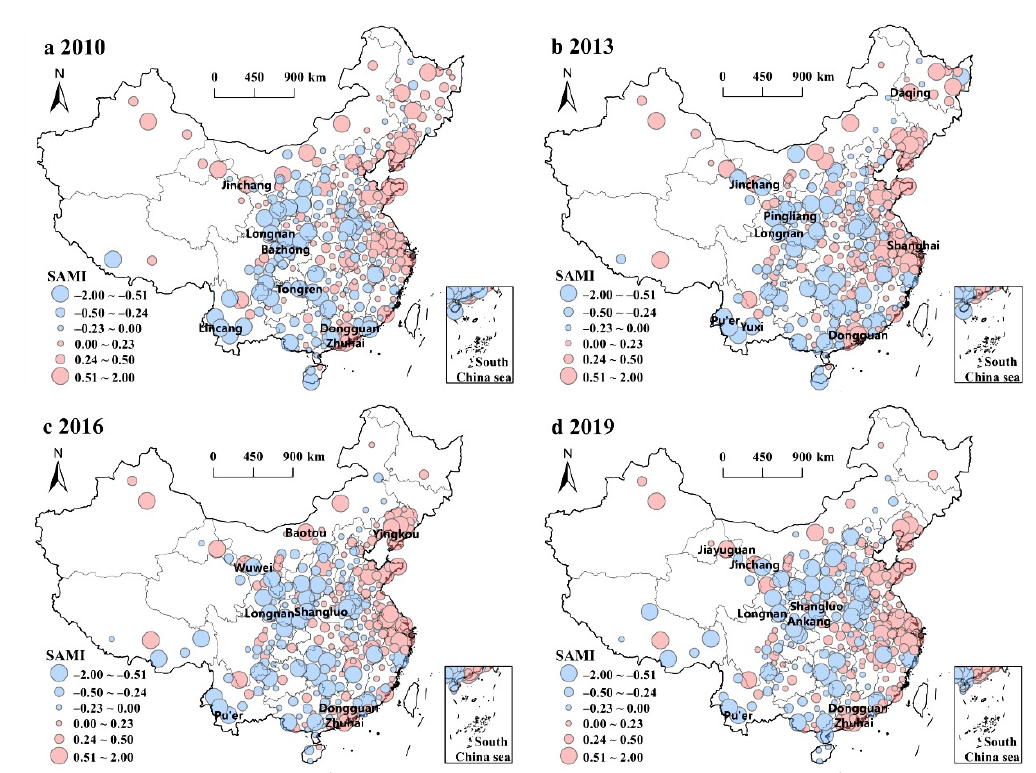
Figure 4. SAMI of urban scaling law of industrial land area in China in 2010–2019.